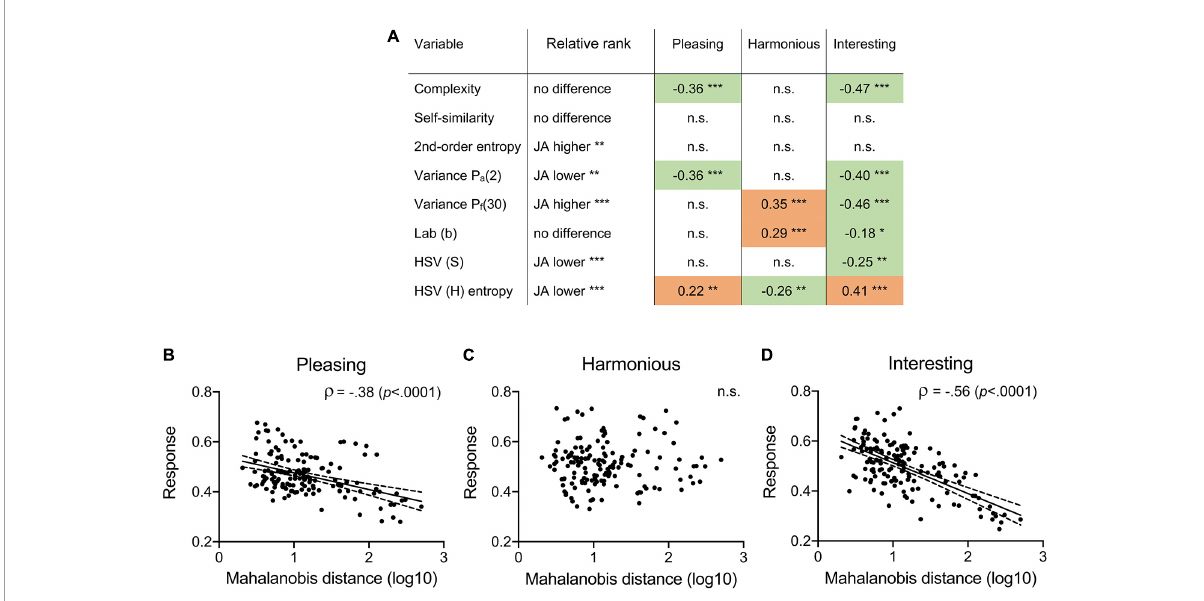
FIGURE8 Influence of the SIPs on the rating responses to the style-transferred images in relation to the median SIP values of the JenAesthetics (JA) dataset. (A) Spearman coefficients ρ for the correlation between the rating responses and the Euclidean distance between each individual SIP and the median SIP of the JenAesthetics dataset, respectively. Negative correlations ( green ) imply that the ratings are higher if the SIPs are closer to the JenAesthetic dataset. The inverse holds for positive correlations ( orange ). The second column lists the rank of the style-transferred images relative to the JA dataset. (B–D) Responses for each rating dimension are plotted as a function of the Mahalanobis distance in the 5d space spanned by the five SIPs that differ significantly between the style-transferred images and traditional Western artworks ( Figure 4 ). Each dot represents one style-transferred image. For the linear regression, the solid line represents the fitted line and the dashed lines its 95% confidence interval. Spearman’s coefficients of correlation ρ are given in (A) and (C) with their respective significance levels. For (A–D) , significance levels are * p < 0.05; ** p < 0.01; *** p < 0.001. n.s., not